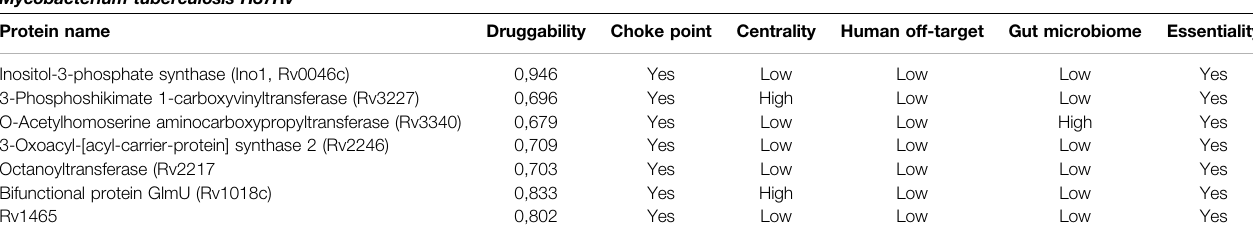
TABLE 2 | Mtb proteins with worthy properties that make them good candidate targets. Mycobacterium tuberculosis H37Rv Protein